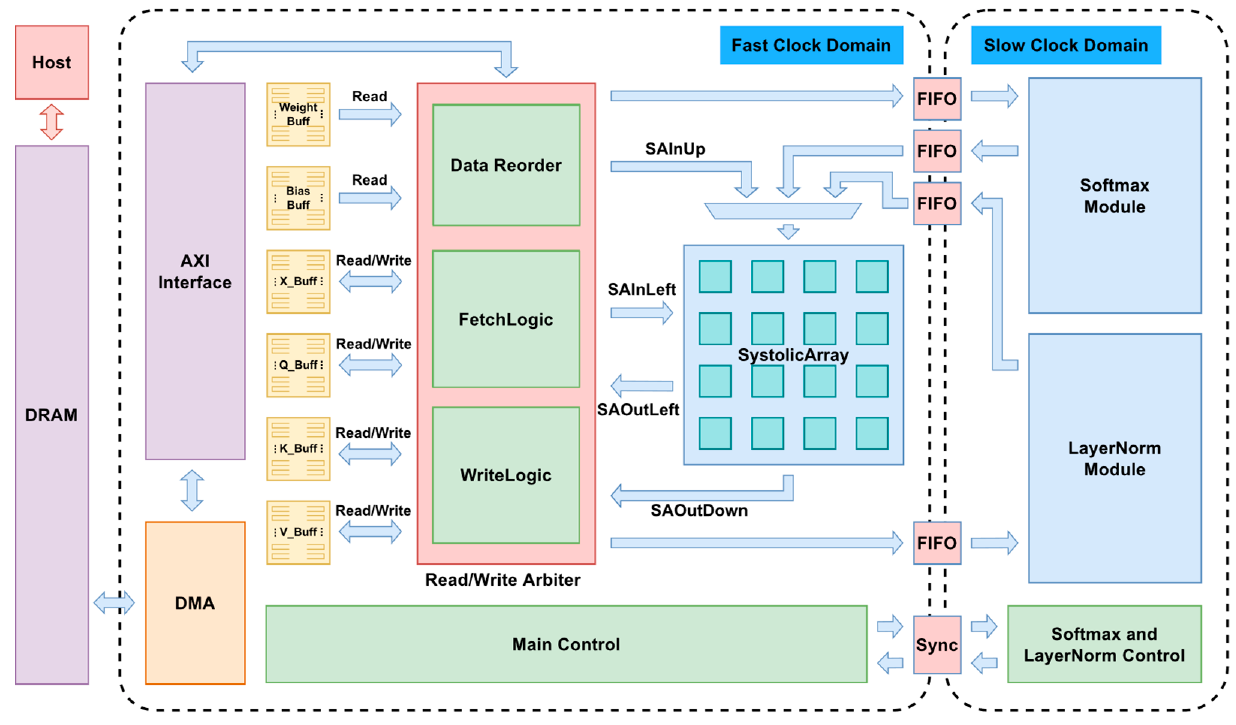
Figure 3. The architecture of the proposed accelerator.